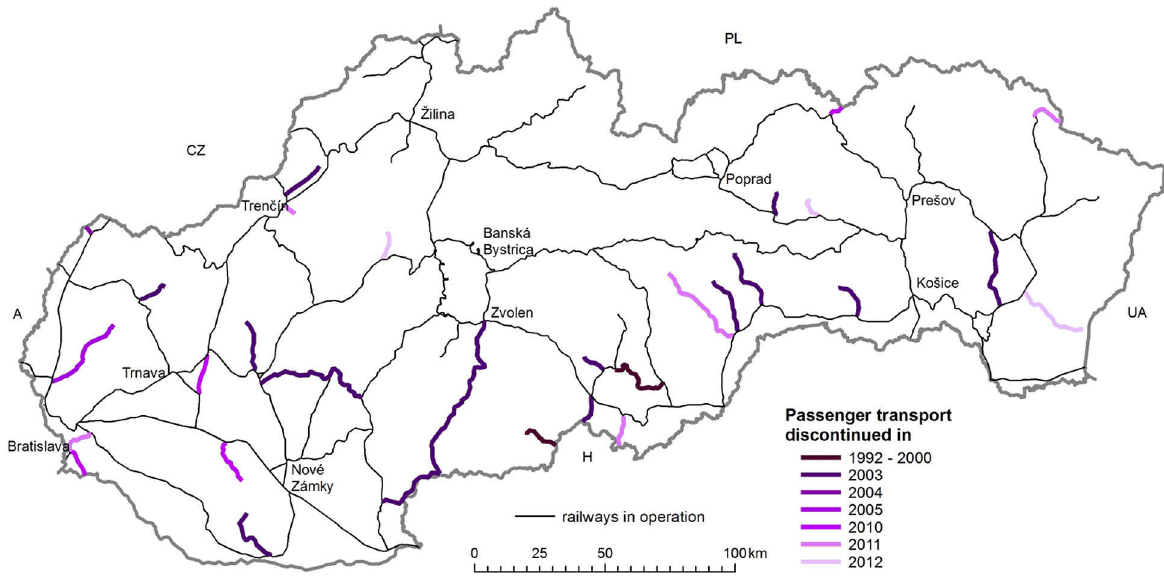
Fig. 6. Railway closures after 1990 in